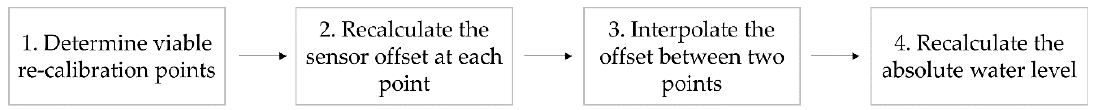
Figure 3. The processes of manual and automated sensor